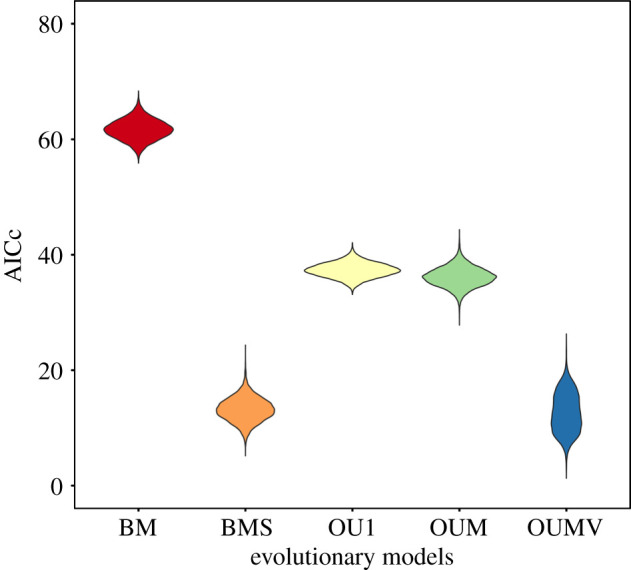
Evolutionary models scored according to the Akaike information criterion corrected for small sample size (AICc). Results from 10 000 simulations, using the OUwie package of R. Smaller values of AICc indicate greater support for the model. BM, Brownian motion; BMS, multi-regime Brownian motion model; OU1, single-peak Ornstein–Uhlenbeck model; OUM, multi-peak Ornstein–Uhlenbeck model; OUMV, multi-peak Ornstein–hlenbeck model with variable σ2 between social systems. (Online version in colour.)